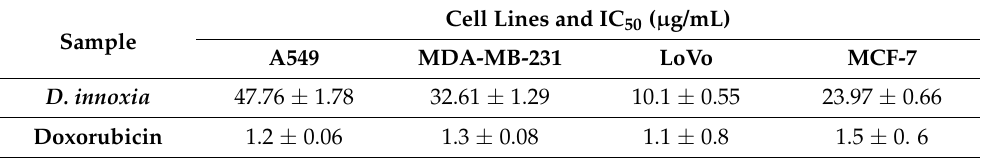
Table 2. Cytotoxic activity of D. innoxia ethanolic extract against different cancer cells. Sample